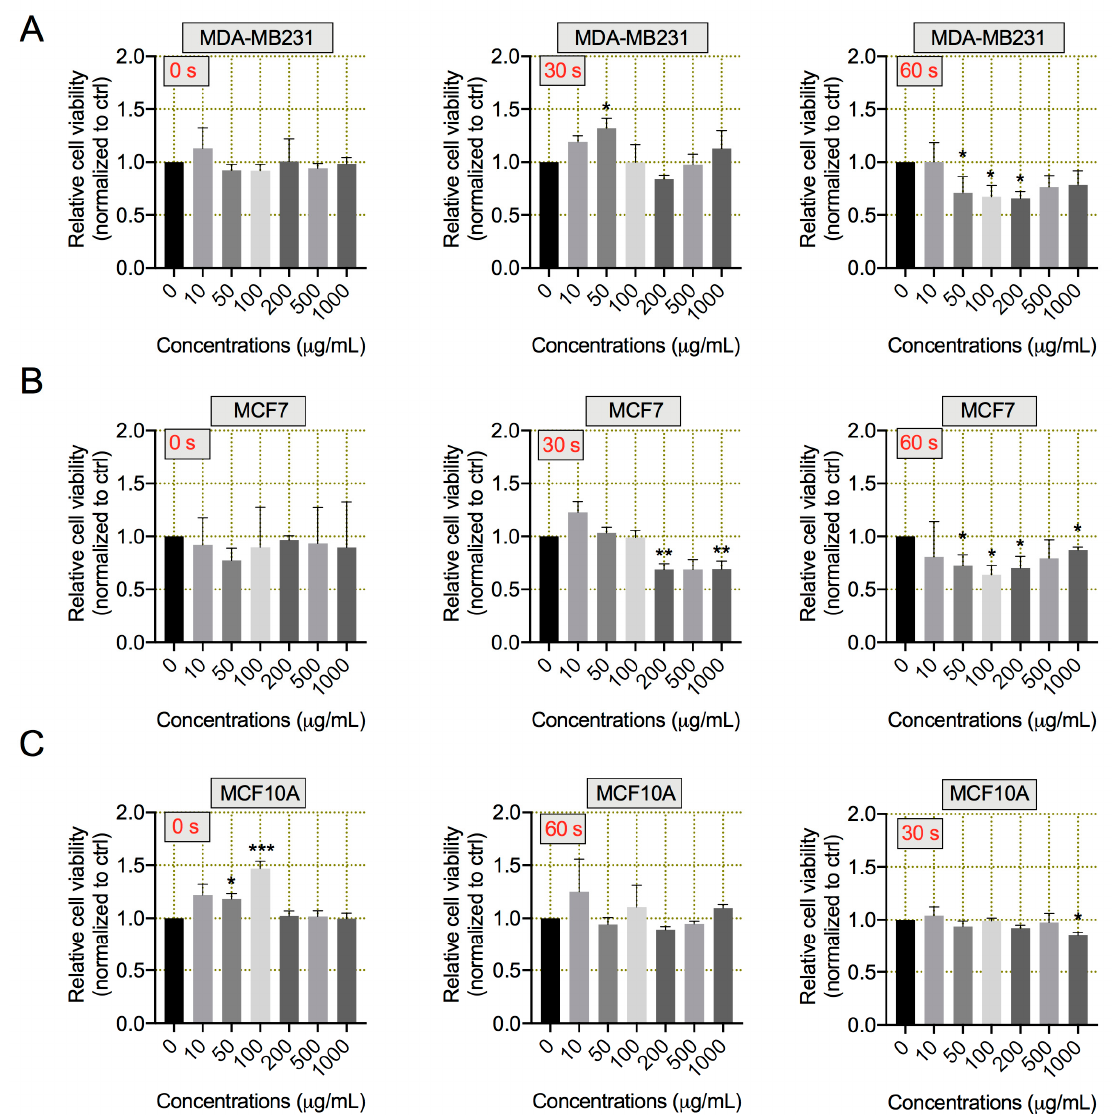
Figure 4. Extracts derived from plasma-treated mushrooms are cytotoxic to breast cancer cells. ( A – C ) Results of Alamar Blue assays performed using MDA-MB231, MCF7 cancer, and MCF10A normal cells incubated for 24 h with 0, 10, 50, 100, 200, 500, and 1000 µg mL − 1 of extracts derived from plasma- treated mushrooms for 30 s, 60 s, or left unexposed (0 s, control). * p < 0.05, ** p < 0.01, and *** p < 0.001. Untreated sample was used as a control in all tested plant extracts groups for normalization.